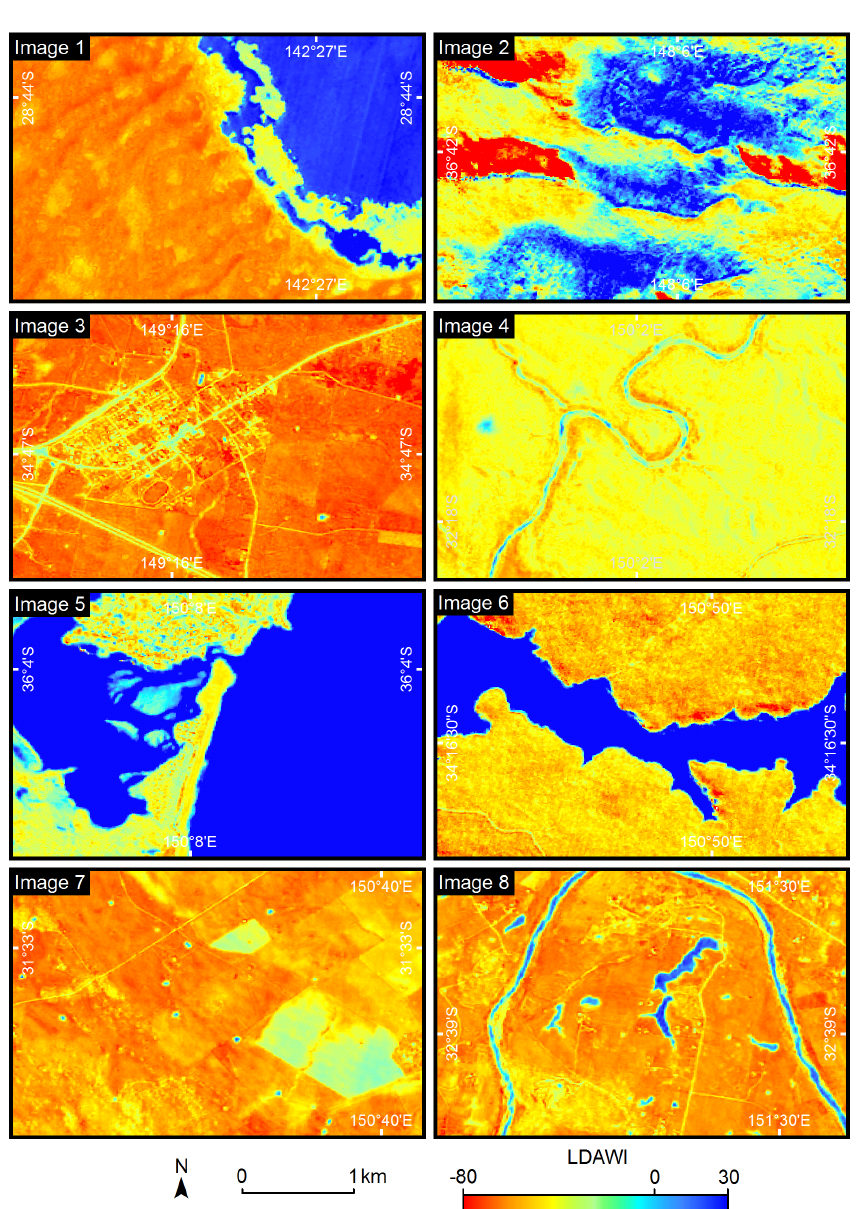
Figure 7. Linear discriminant analysis water index (LDAWI) images for the image subsets shown in Figure 3, where water (including snow) is blue and non-water is red. Water is present as ephemeral playa lakes (Image 1), snow covered forest (Image 2), small dams close to urban areas (Image 3), rivers within forests (Image 4), coastal estuaries and beaches (Image 5), large dams (Image 6), small dams (Image 7) and rivers within farmland (Image